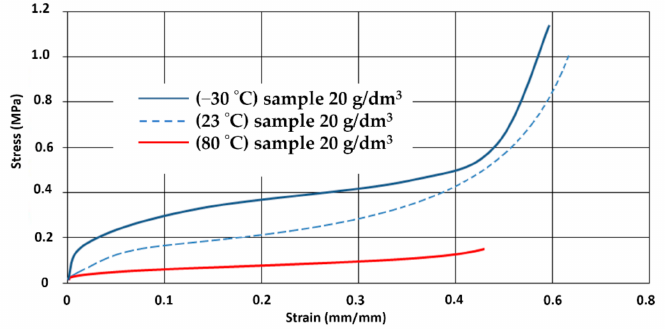
Figure 12. The stress–strain curves of EPP foam (density 20 g/dm 3 ) at a quasistatic loading, strain rate of 2 mm/s and different temperature, sample size 20 mm × 20 mm, 30 mm